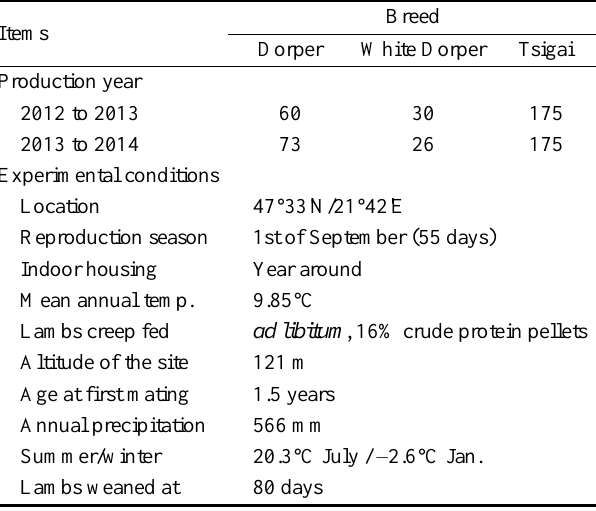
Table 1. Number of ewes in the study herd and data on the experimental